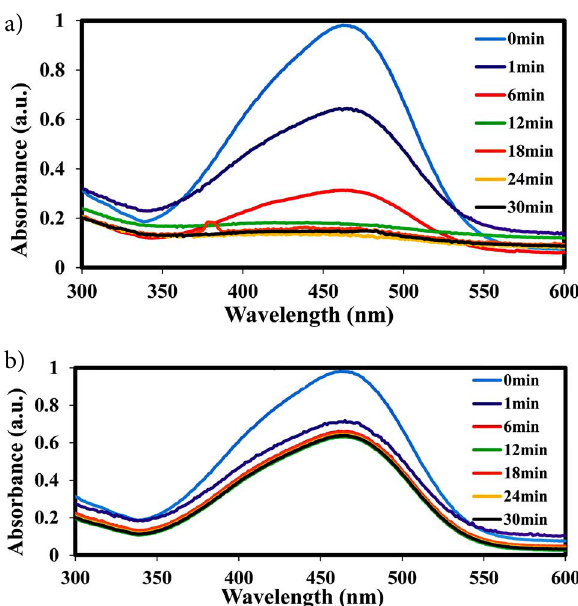
Fig 9. Time-dependent UV-vis absorption spectra for the reduc- tion of MO with NaBH 4 (a) in presence and (b) absence of Ag/ HNTs at room